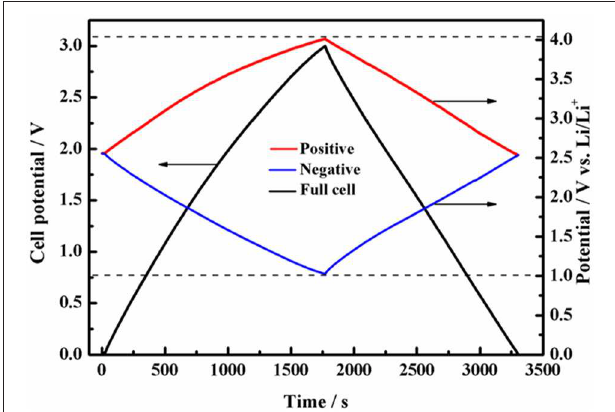
FIGURE 5 | Potential profiles of the positive and negative electrodes during galvanostatic charge/discharge of symmetric supercapacitor with 1mol L − 1 Py 13 DFOB/PC.